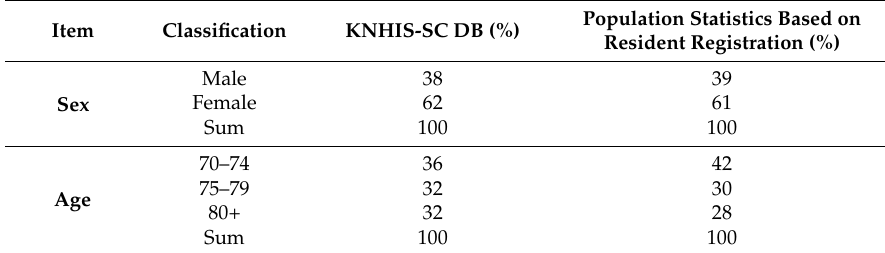
Table 1. Comparison of KNHIS-SC DB and Resident registration population construct ration according to sex, age, and region (as of